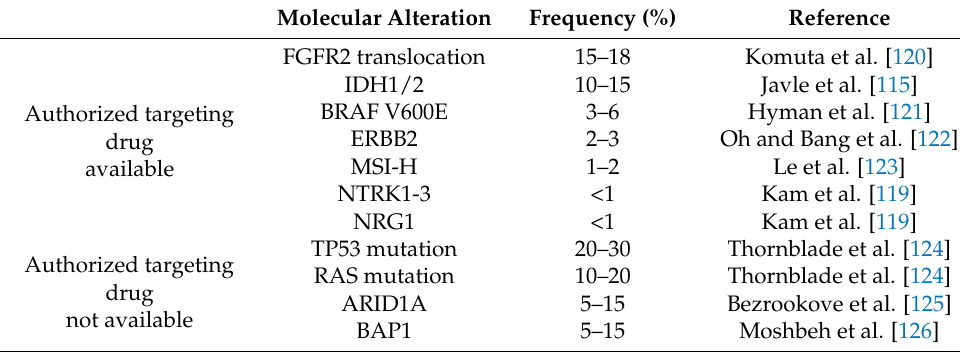
Table 3. Molecular alterations in small duct